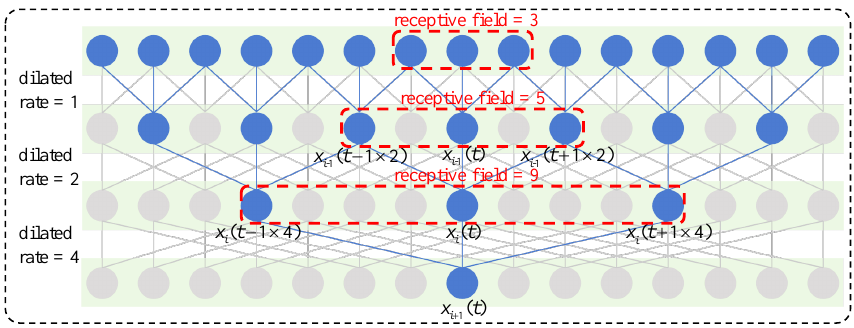
Figure 1. 1D dilated convolution with convolution kernel size